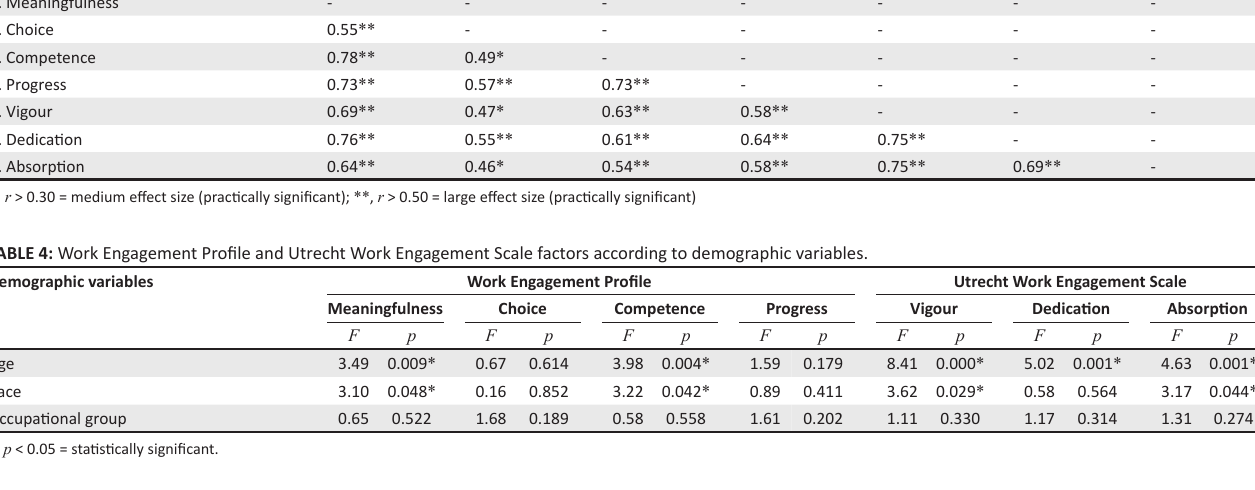
TABLE 3: Pearson product moment correlation coefficients. Variable